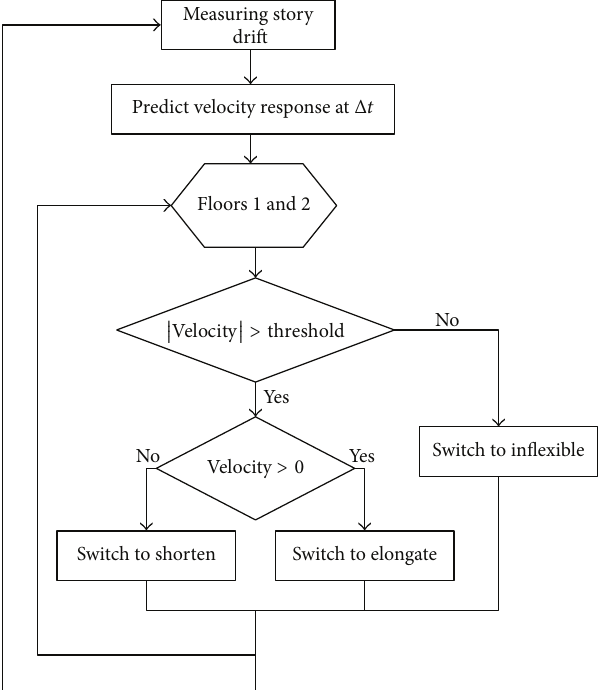
Figure5:Thesignalprocessflowchartofthisfull-scaleshakingtable